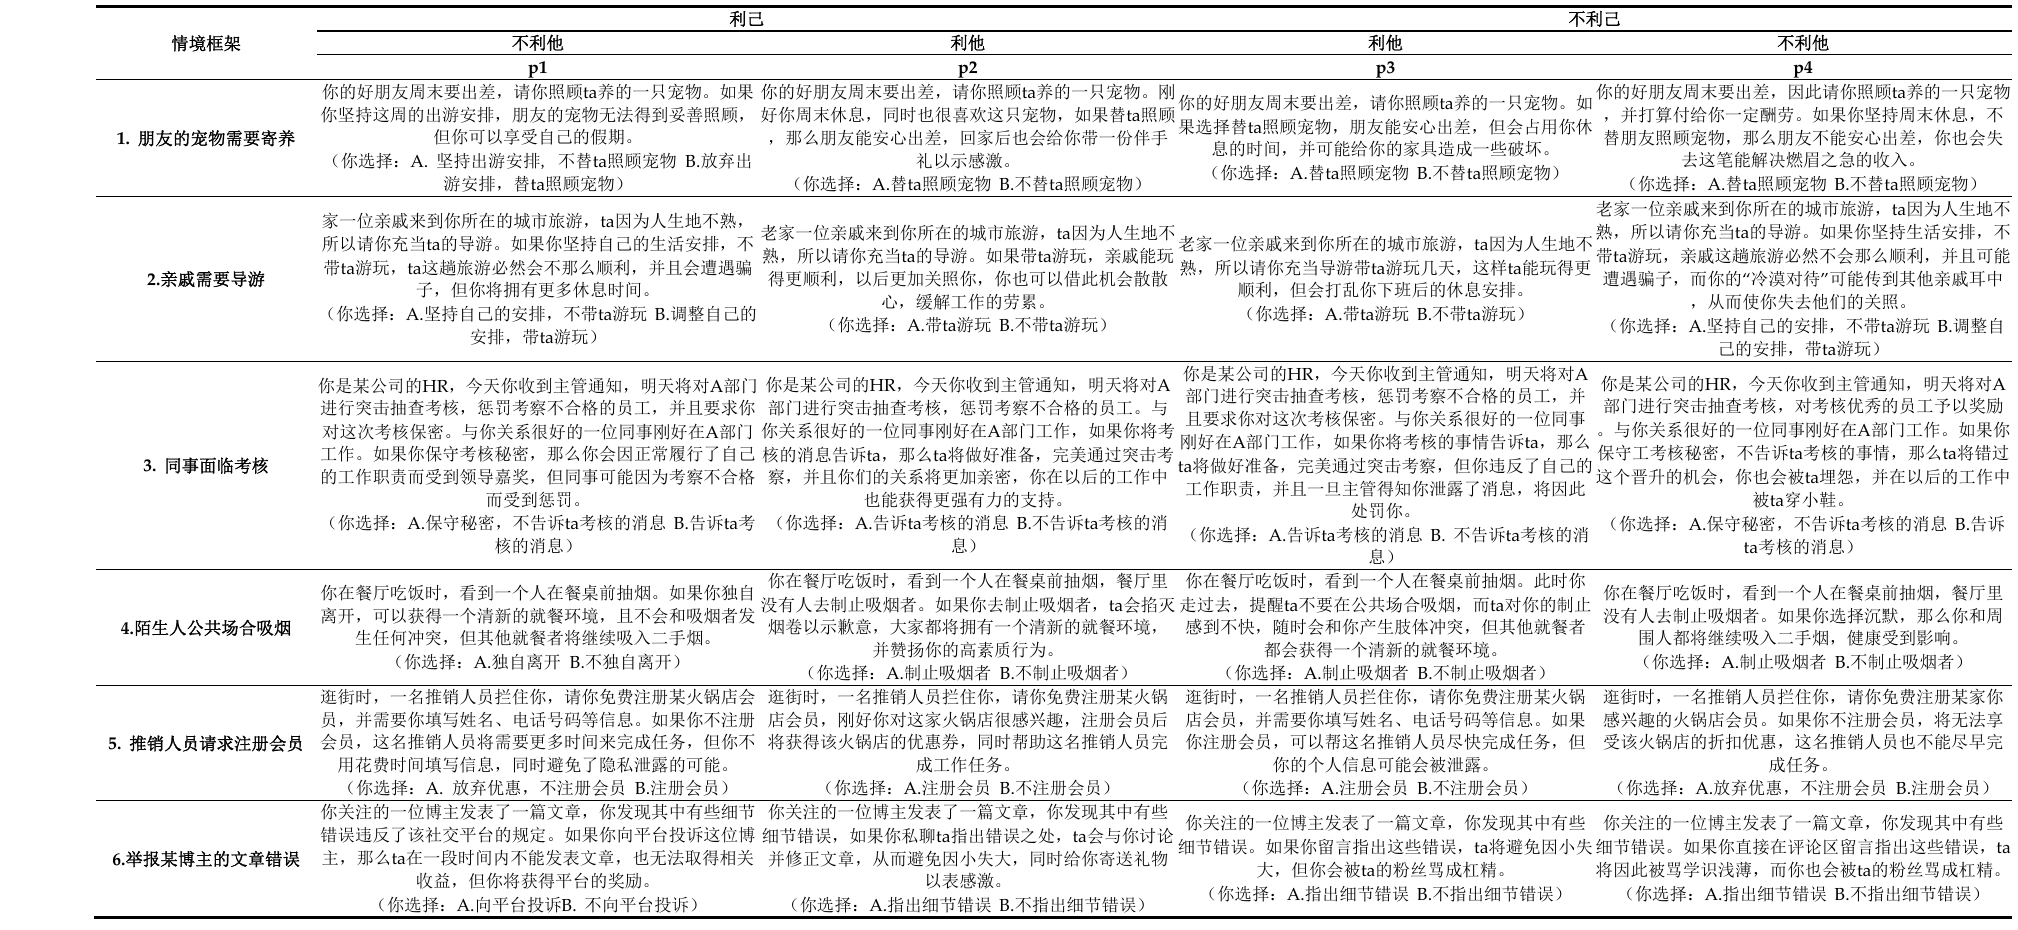
Table A2. The Six Frameworks with a Total of 24 Scenarios Retained in Study 1 (in